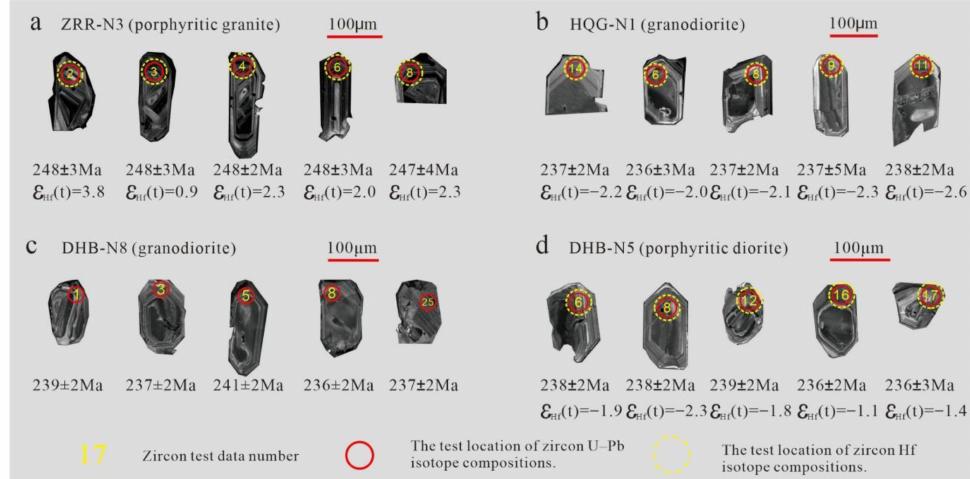
Figure 4. The representative cathodoluminescence (CL) images of zircons from the intermediate-acid intrusive rocks in the Ela Mountain area. Red and yellow circles indicate the locations of the LA- ICP-MS U-Pb analyses and Lu-Hf isotope analyses, respectively. ( a ) The representative CL images of zircons from ZRR-N3 (porphyritic granite). ( b ) The representative CL images of zircons from HQG-N1 (granodiorite). ( c ) The representative CL images of zircons from DHB-N8 (granodiorte).